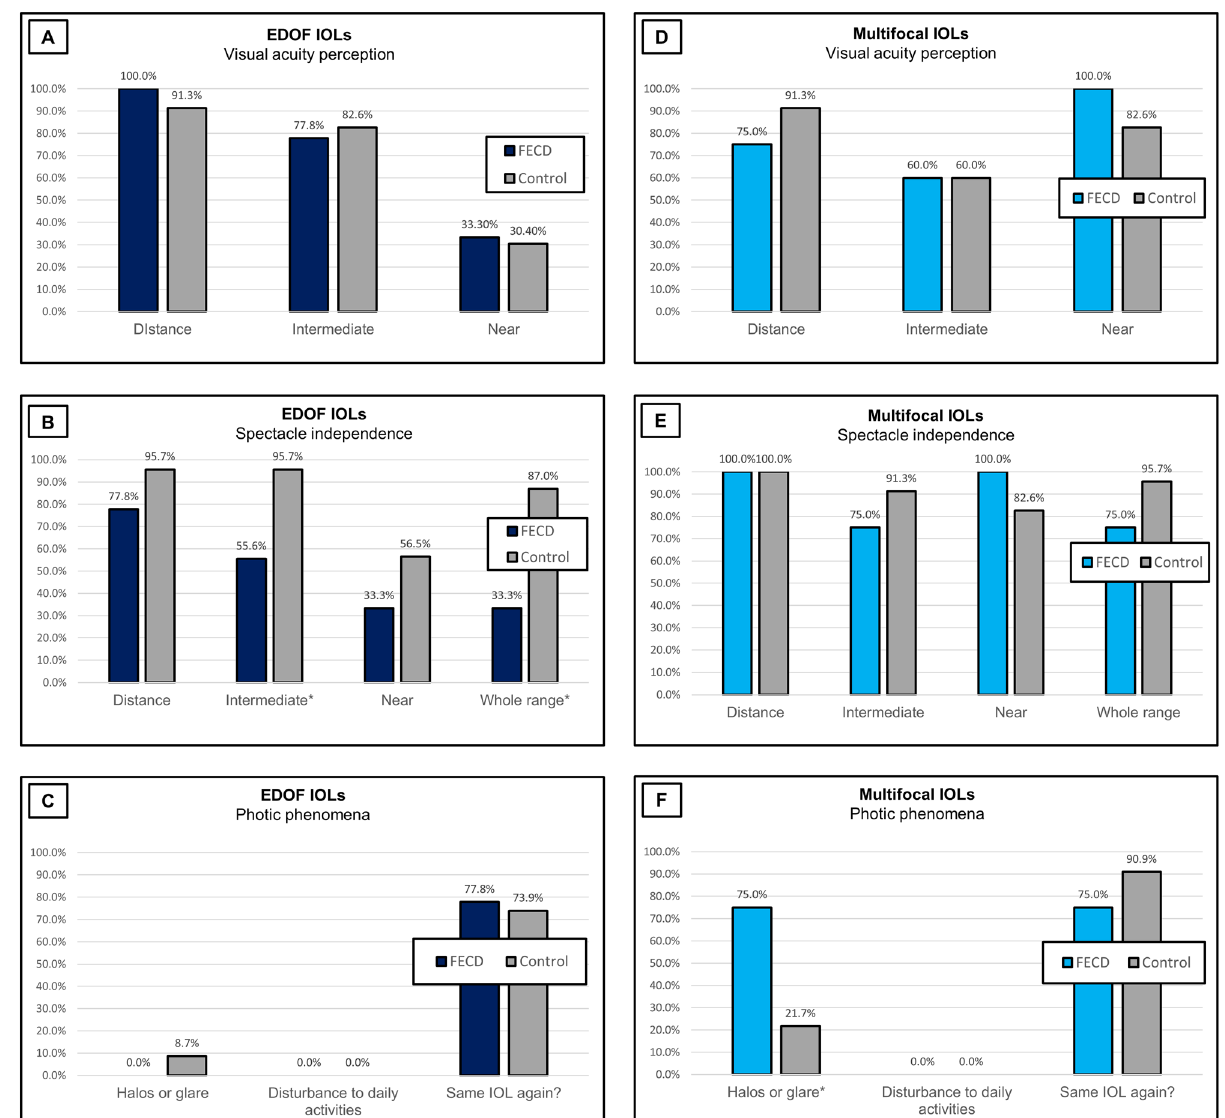
Figure 2. Patients’ self-assessment questionnaire results ( A , D). Visual acuity perception. The percentage of patients in each group who rated their uncorrected visual acuity as “excellent” or “good” for distance, intermediate and near. ( A EDOF IOL subgroup, D Multifocal IOLs subgroup). ( B , E). Spectacle independence. The percentage of patients in each group who reported they “never” or “rarely” use spectacles for distance, intermediate, near and overall. ( B EDOF IOLs subgroup, E - Multifocal IOLs subgroup). ( C , F) Photic phenomena. The percentage of patients in each group who reported having halos or glare, and the percentage of patients in each group who reported disturbances in daily life activity from the halos or glare “often” or “all the time”. Satisfaction—the percentage of patients in each group who answered “probably” or “yes” to the question: “Would you choose the same IOL again?”. ( C . EDOF IOLs subgroup, F . Multifocal IOLs subgroup).*Statistically significant (IOLs = intraocular lenses, EDOF = extended depth of focus, FECD = Fuchs endothelial corneal light among patients with mild FECD without corneal edema. They concluded that corneal guttae caused poorer quality of vision in eyes with mild FECD. FECD patients demonstrated a trend toward higher preoperative corneal astigmatism magnitude in the EDOF subgroup ( P = 0.08) and higher preoperative corneal astigmatism magnitude in the multifocal group ( P = 0.002). However, with implantation of toric IOLs, the postoperative residual refractive astigmatism magnitude in both the EDOF IOLs and the multifocal IOLs groups were similar for the FECD and the control patients ( P = 0.52, P = 0.61, respectively). The only subgroup with higher residual refractive astigmatism was the EDOF-toric-IOL subgroup, in which the postoperative refractive astigmatism among FECD patients was significantly higher compared with the healthy controls ( P < 0.001 vs. P = 0.03, respectively; Table 5). It may explain the inferior UDVA ( P = 0.007), and the better UNVA ( P = 0.001) among the FECD patients implanted with EDOF IOLs, and